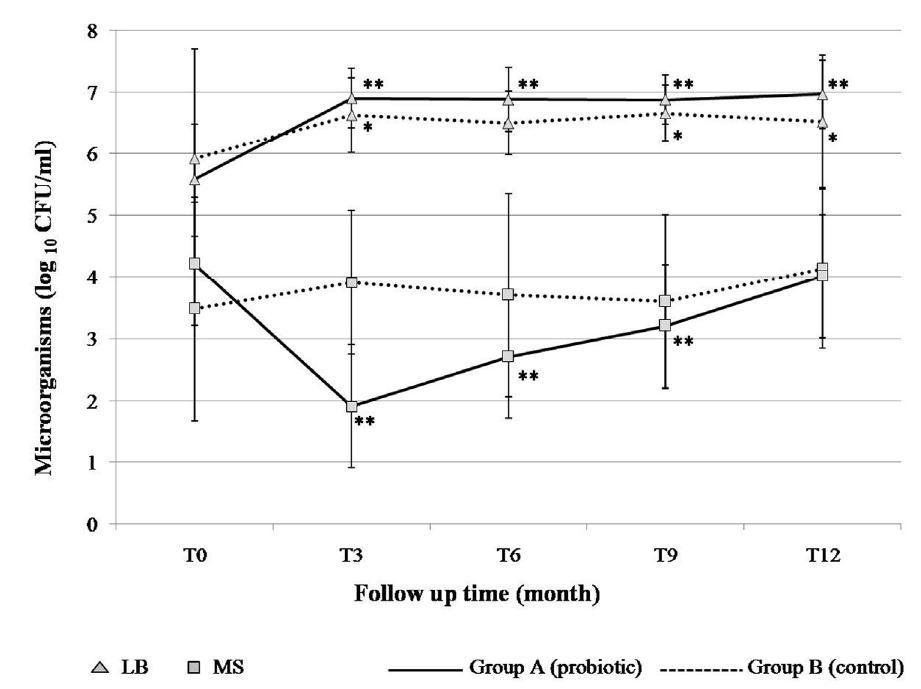
Figure 2. The number of salivary mutans streptococci (MS) and lactobacilli (LB) at the baseline (T0) and during the 12 months of study (T3–T12). The parameters were evaluated by the Wilcoxon signed-rank test: * Significance ( P < 0.05), ** Significance ( P < 0.001) difference versus